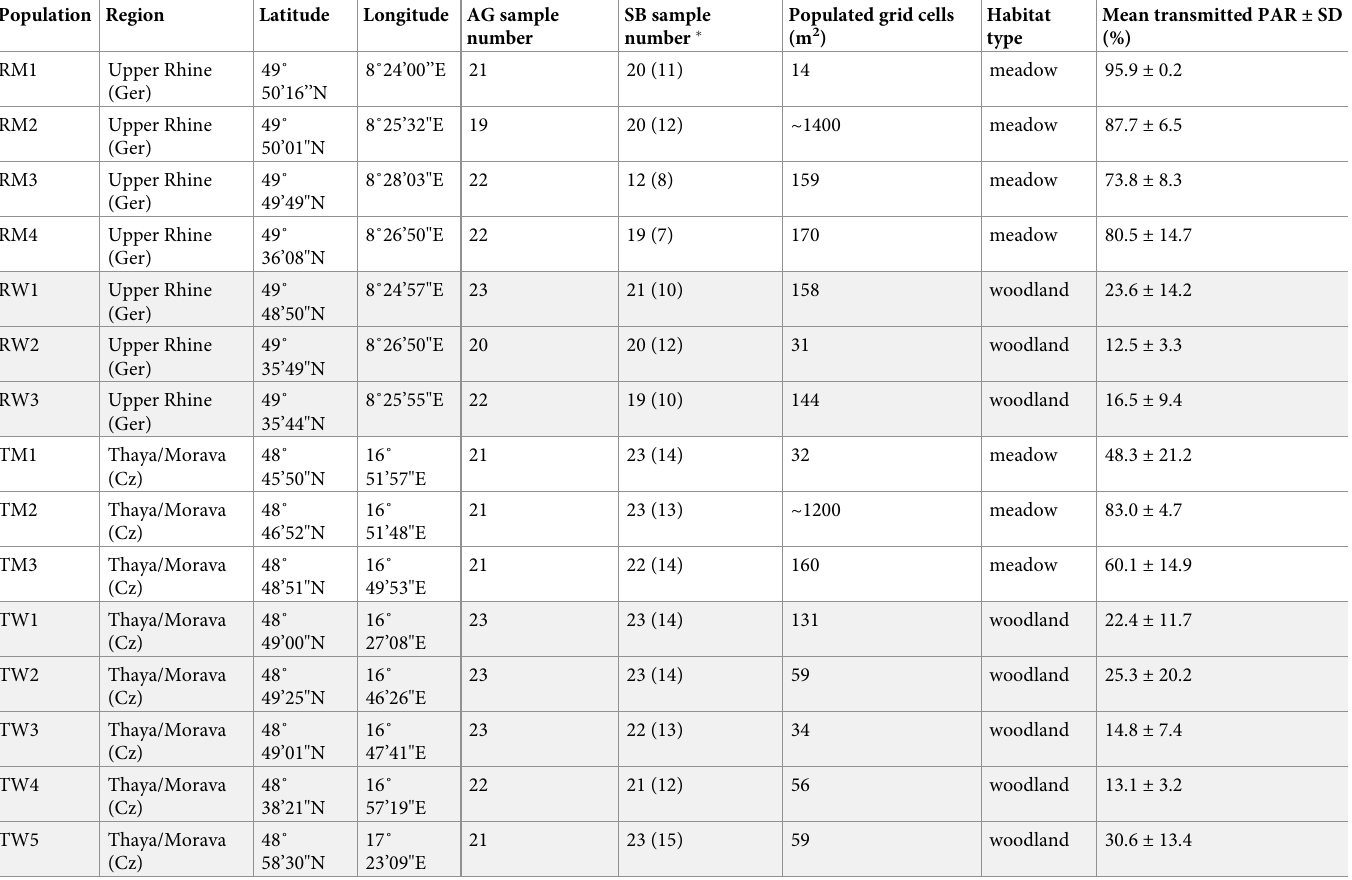
Table 1. Overview of surveyed populations of Viola elatior . Population